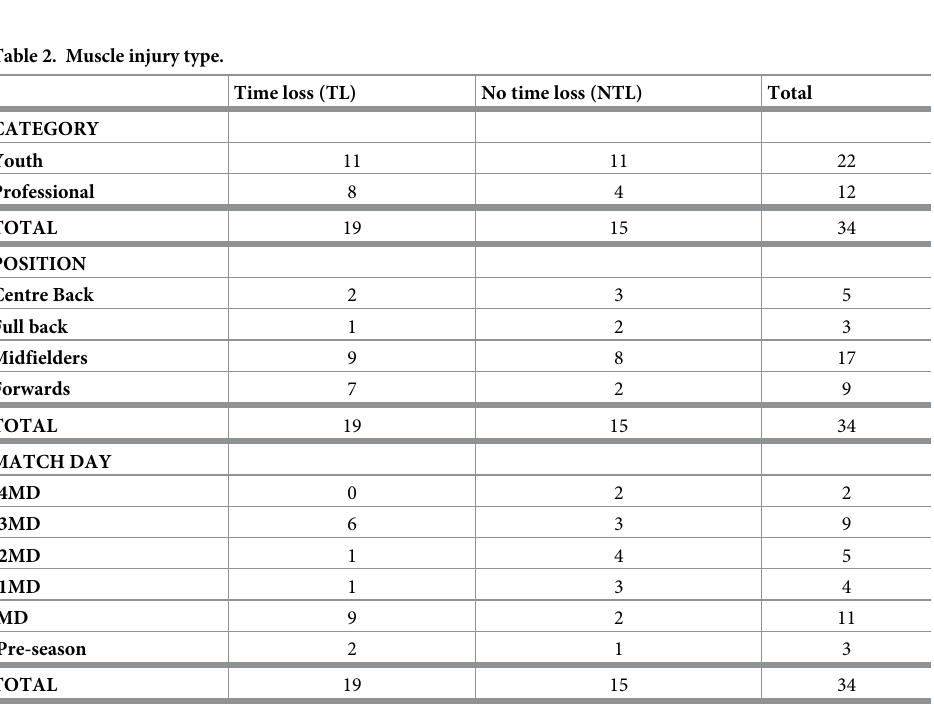
Table 2. Muscle injury